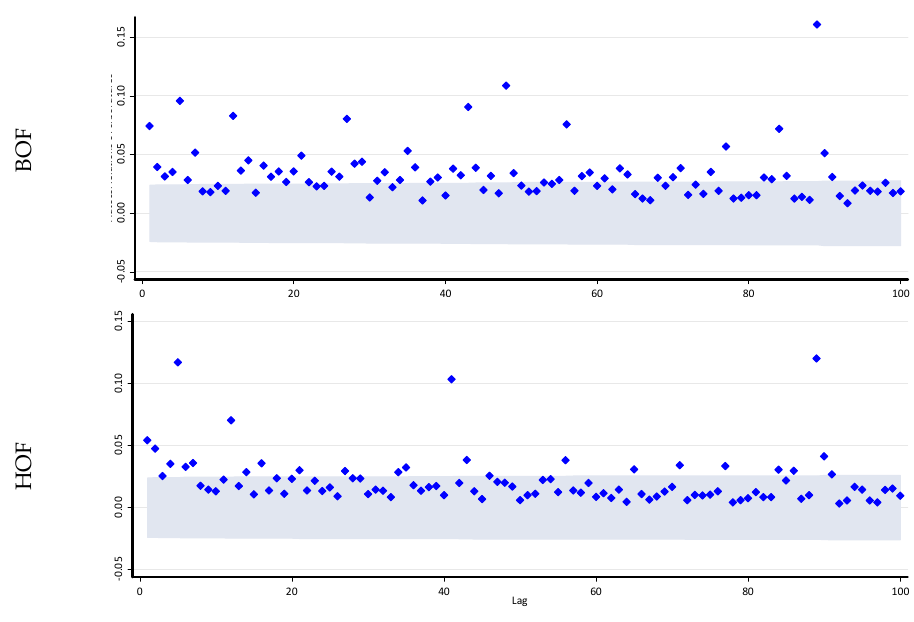
Figure 1. Autocorrelation of Squared Returns.